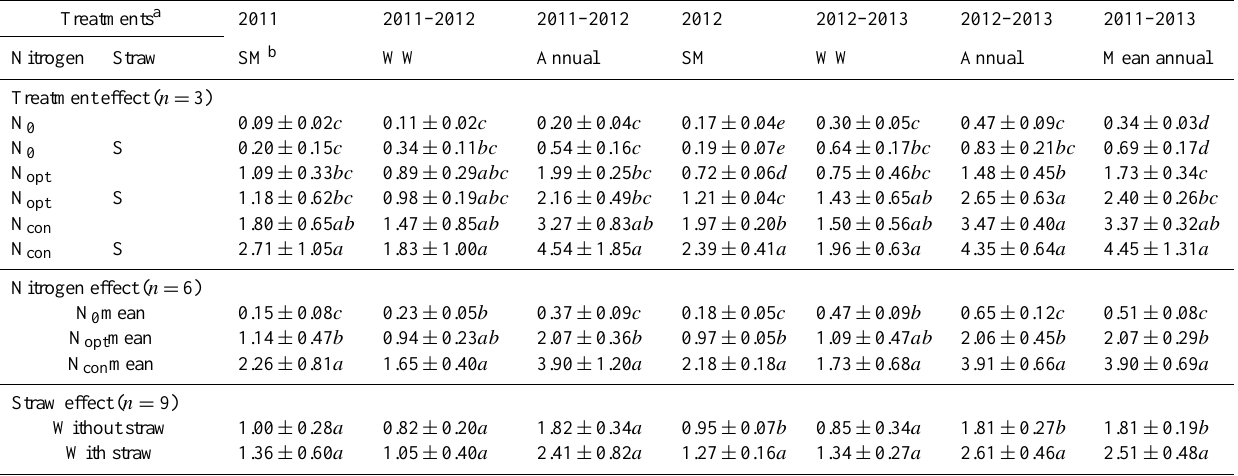
Table 5. N 2 O emissions (kg N 2 O-Nha − 1 ) in winter wheat–summer maize double-cropping system from June 2011 to June 2013.